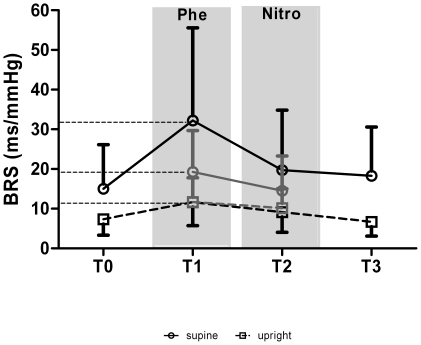
Time course of spectrally determined (black line) and of drug-induced (grey line) BRS during the course of the modified Oxford maneuver.T0, baseline; T1, phenylephrine; T2 nitroprusside; T3, recovery. Data are means ± SD.